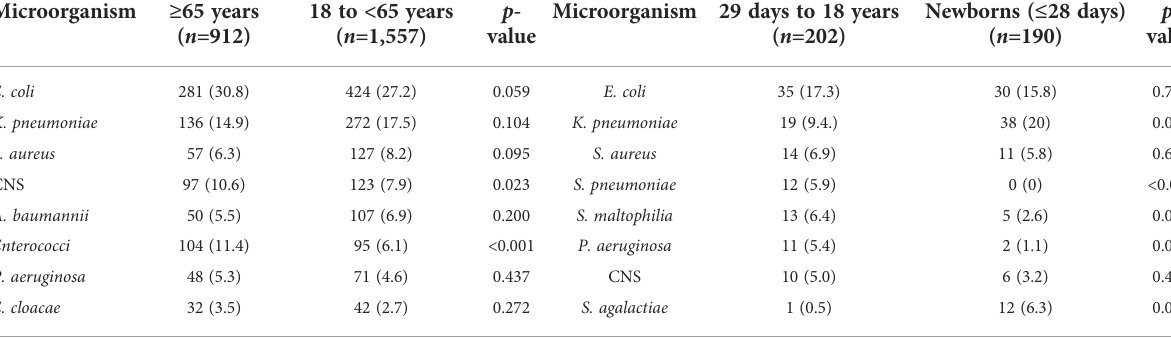
TABLE 5 Distribution of pathogens isolated from bloodstream infections in terms of age